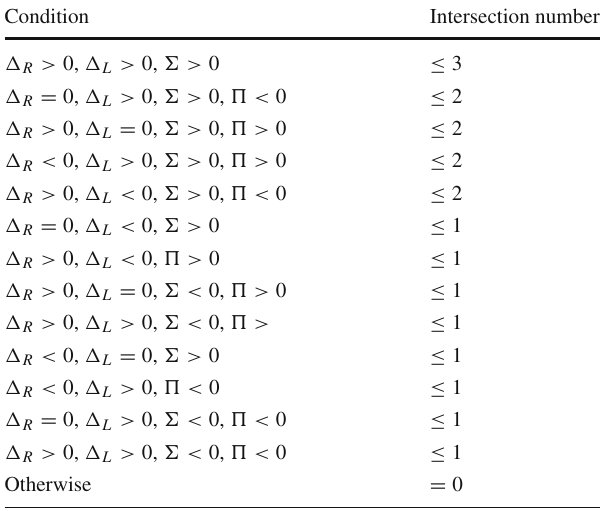
Table 6 Constraints on the intersection number for the critical points φ ± when the action is PT symmetric Condition